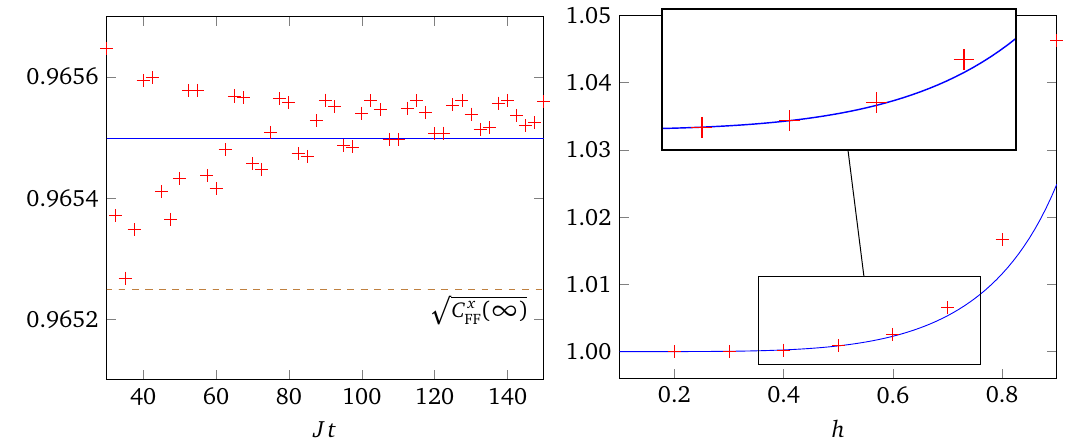
( t ) 〉 e t /τ with τ defined in (132) as a 1 = 0.1 to h = 0.5, corresponding to a den- 0 ) (96) is shown in blue and is Q (cid:112) ξ = 0.1 to h as a , for quenches from h 0